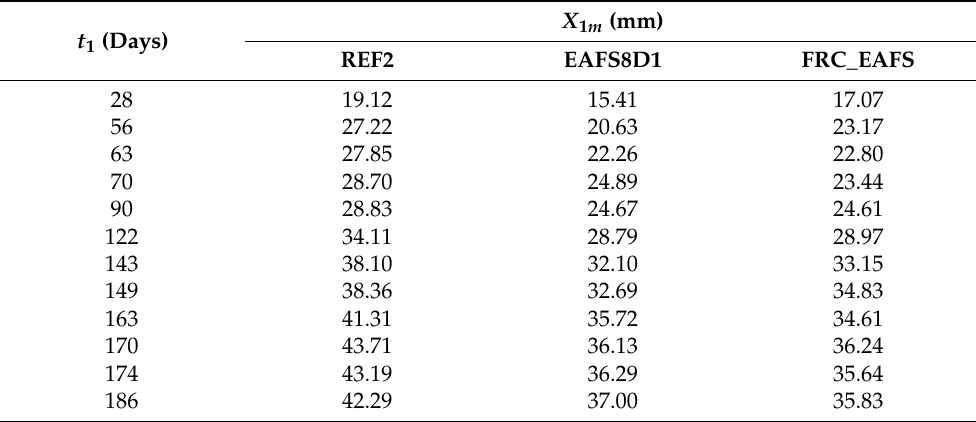
Table 19. Results of average carbonation depth, X 1 m , for the REF2 mixture and for the mixtures designed with EAFS and RTSF.